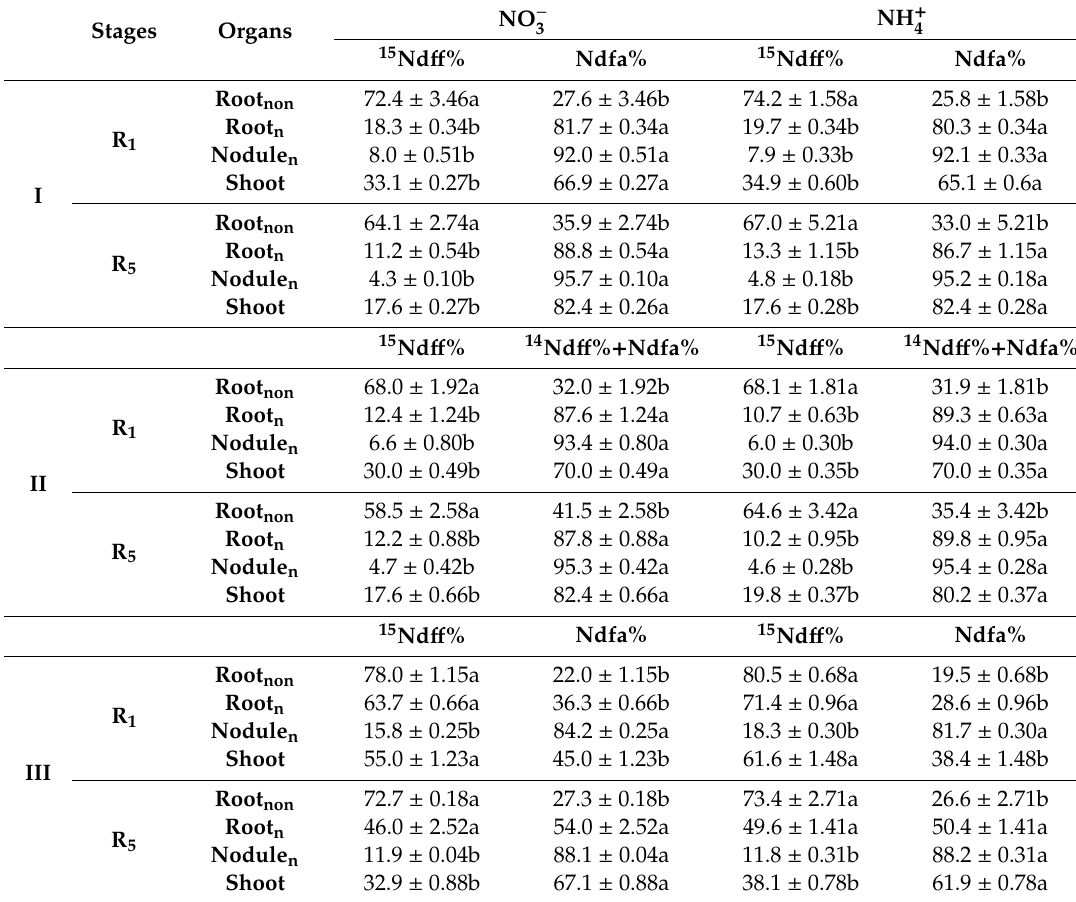
Table 3. Ratio of N absorbed from di ff erent sources in dual root soybeans